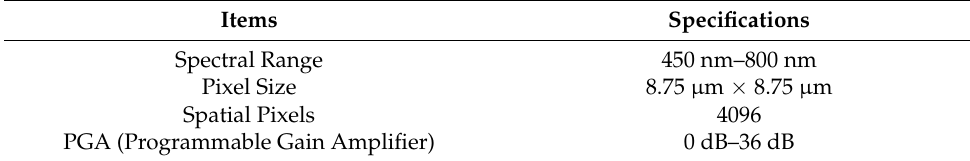
Table 1. The main technical indicators of the imaging